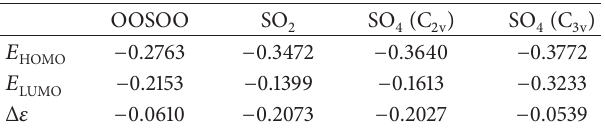
Table 5: HOMO and LUMO energies (in atomic unit) of OOSOO, , SO (C 2 ), and SO SO 2 4 v